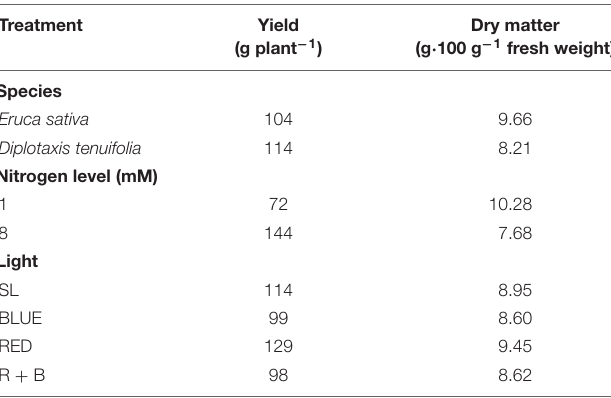
TABLE 3 | Average yield and dry matter of rocket as a function of light treatment, nitrogen level and species.